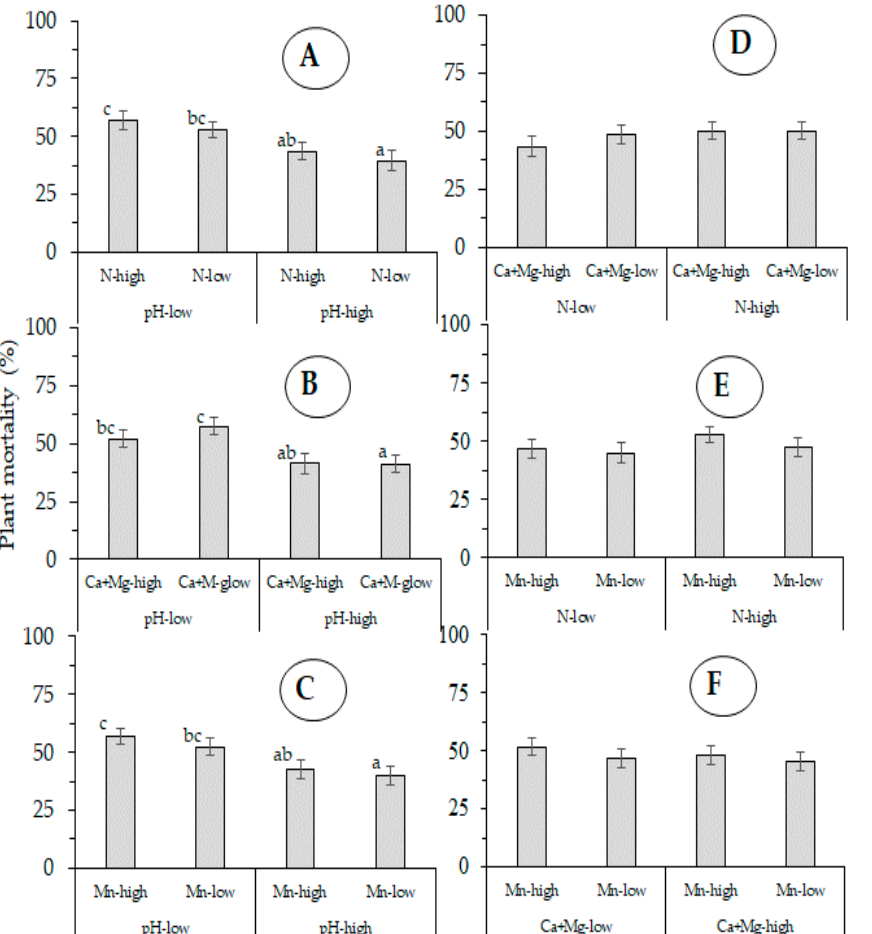
Figure 7. Aggregated effect of the interaction of five soil chemical properties: ( A ): pH-N, ( B ): pH- CaMg, ( C ): pH-Mn, ( D ): N-CaMg, ( E ): N-Mn and ( F ): CaMg-Mn, on plant mortality by Fusarium wilt (Foc Race 1) of Gros Michel banana after four crop cycles in Exp-east (28 Millas, Costa Rica). (error bars represent the standard error).